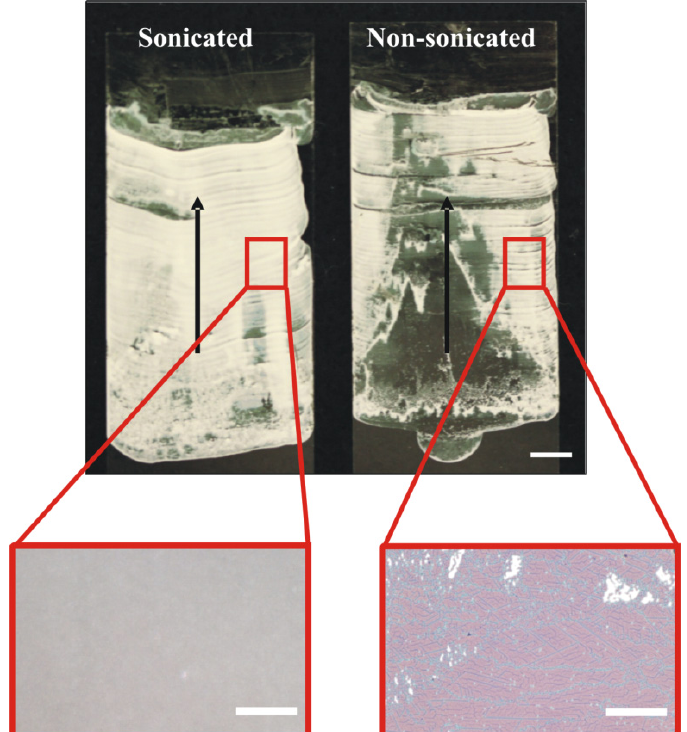
Figure 5. Structure of coatings deposited from a 1.0 µm microsphere suspension when the tubing of the delivery system is vibrated at 400 Hz ( left ) or without vibration ( right ). The non-sonicated fluid delivery system coating has uneven particle distribution along its length and width whereas the vibrated coating is highly uniform with no pronounced particle aggregation along the substrate edges. Scale bars for coating images and micrographs are 5 mm and 50 µm, respectively; arrows indicate direction of